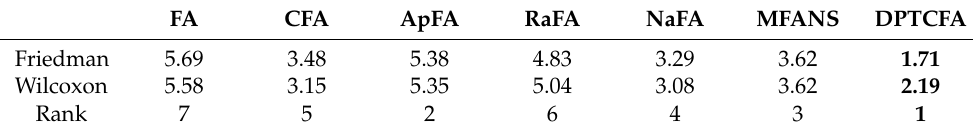
Table 7. Friedman and Wilcoxon test results in different algorithms ( D = 30).